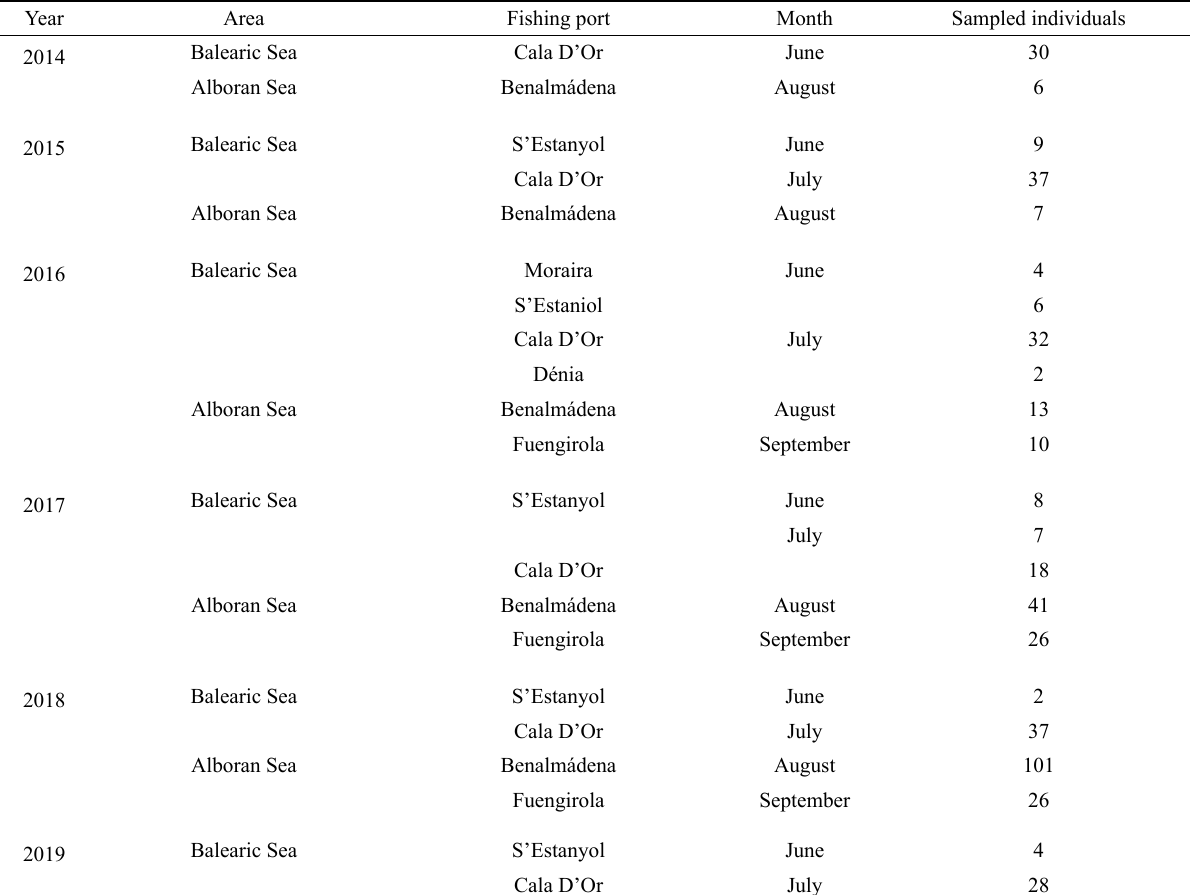
Table 2. – Sampled individuals by year, zone, fishing sport and month in offshore trolling